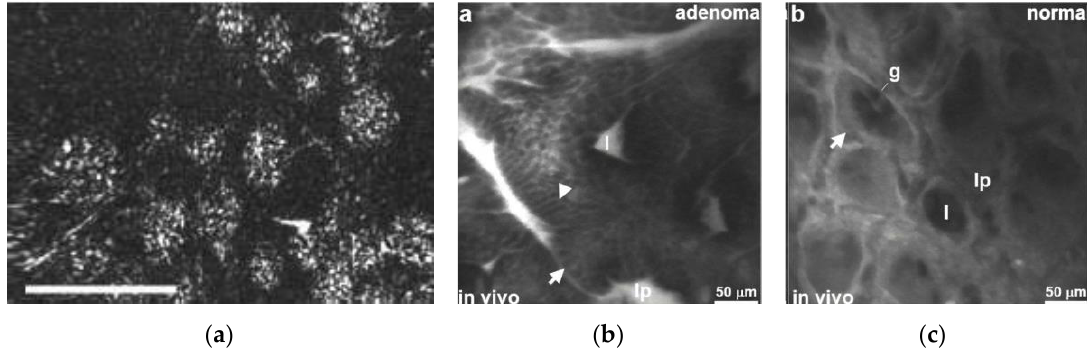
Figure 4. In vivo confocal images: ( a ) reflectance image of tissue phantom with cervical cells and collagen (taken with permission of [20] © The Optical Society); ( b ) fluorescence image of an adenoma mucosa (taken with the permission of [24]); ( c ) fluorescence image of a normal mucosa (taken with the permission of [24]).